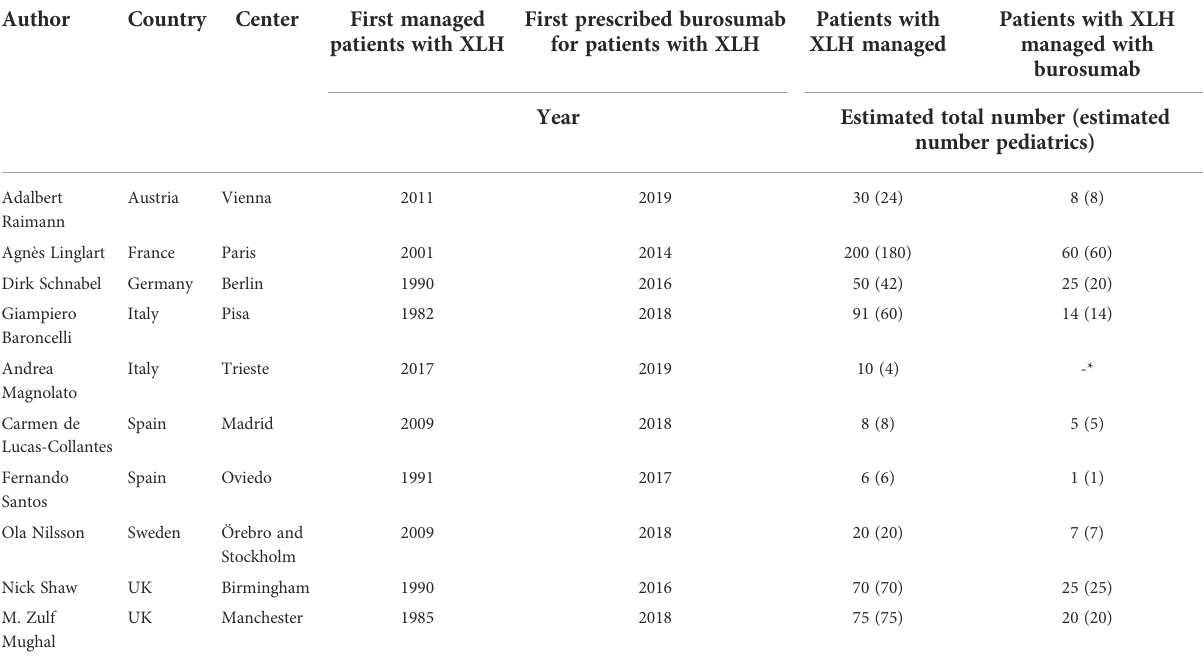
TABLE 1 Expert practice exchange group participants (all authors of this